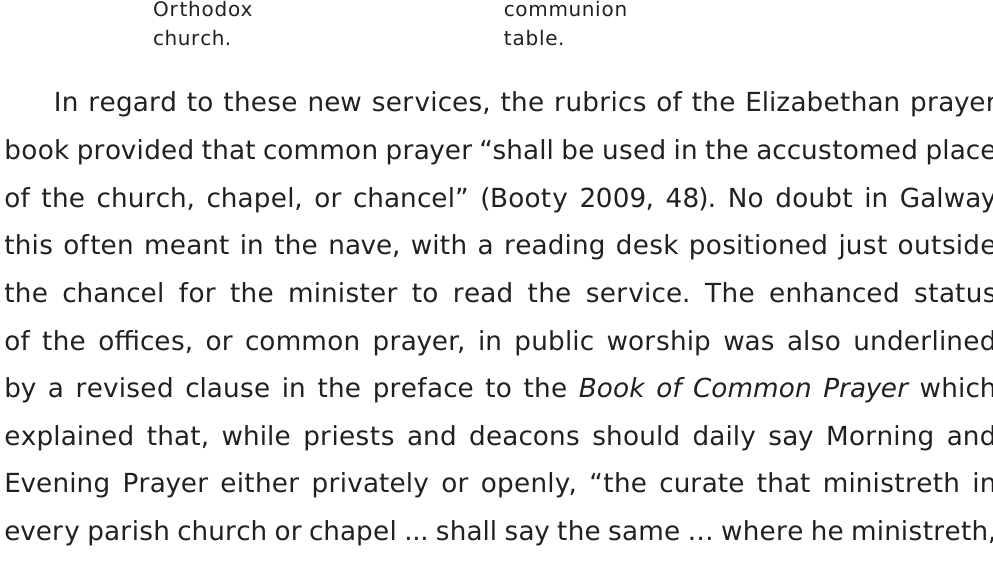
Chancel with high altar and choir